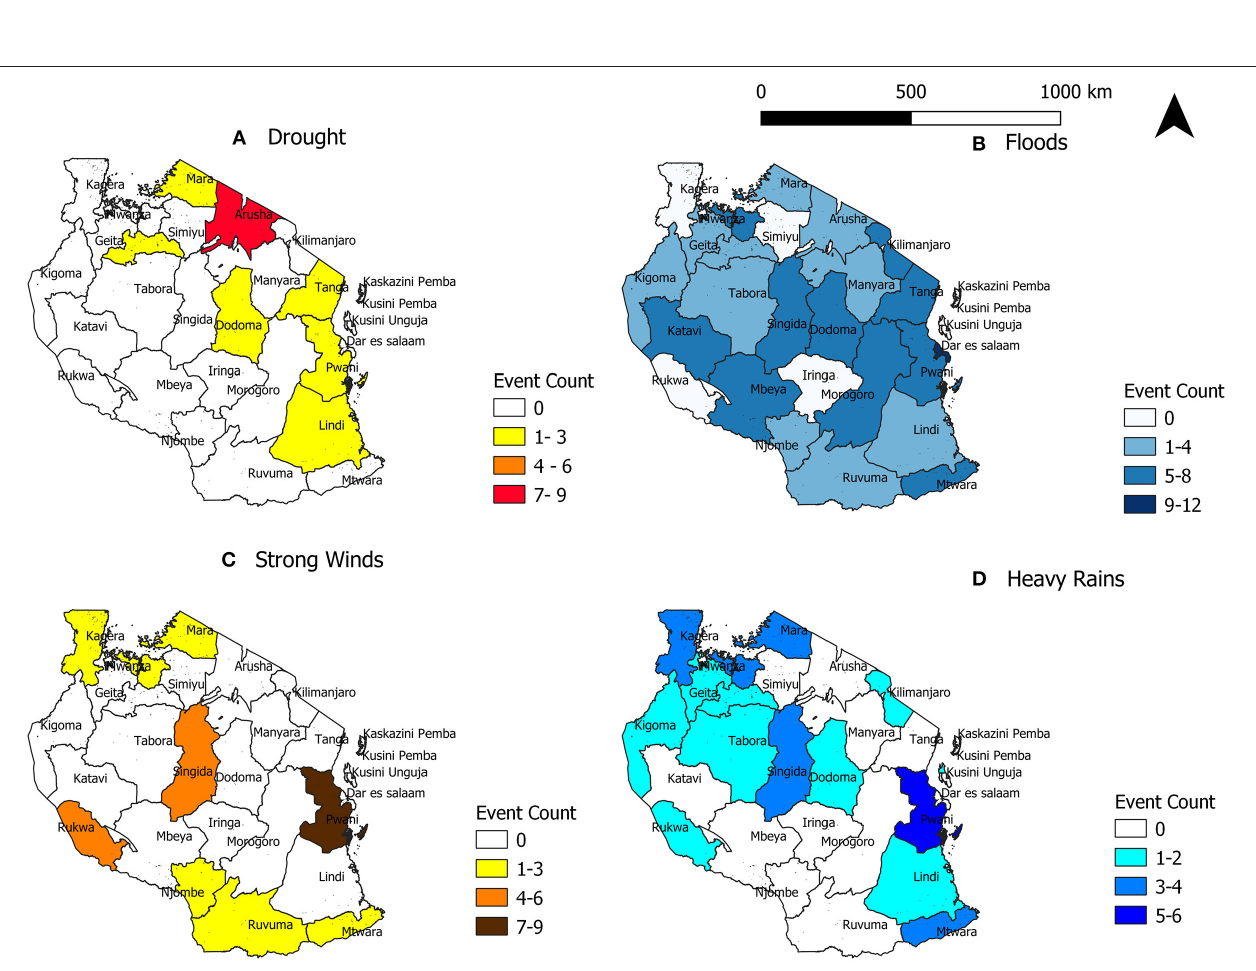
FIGURE 2 | Distribution of weather-related disasters events (drought, floods strong wind, and heavy rainfall) in Tanzania (2000–2019).